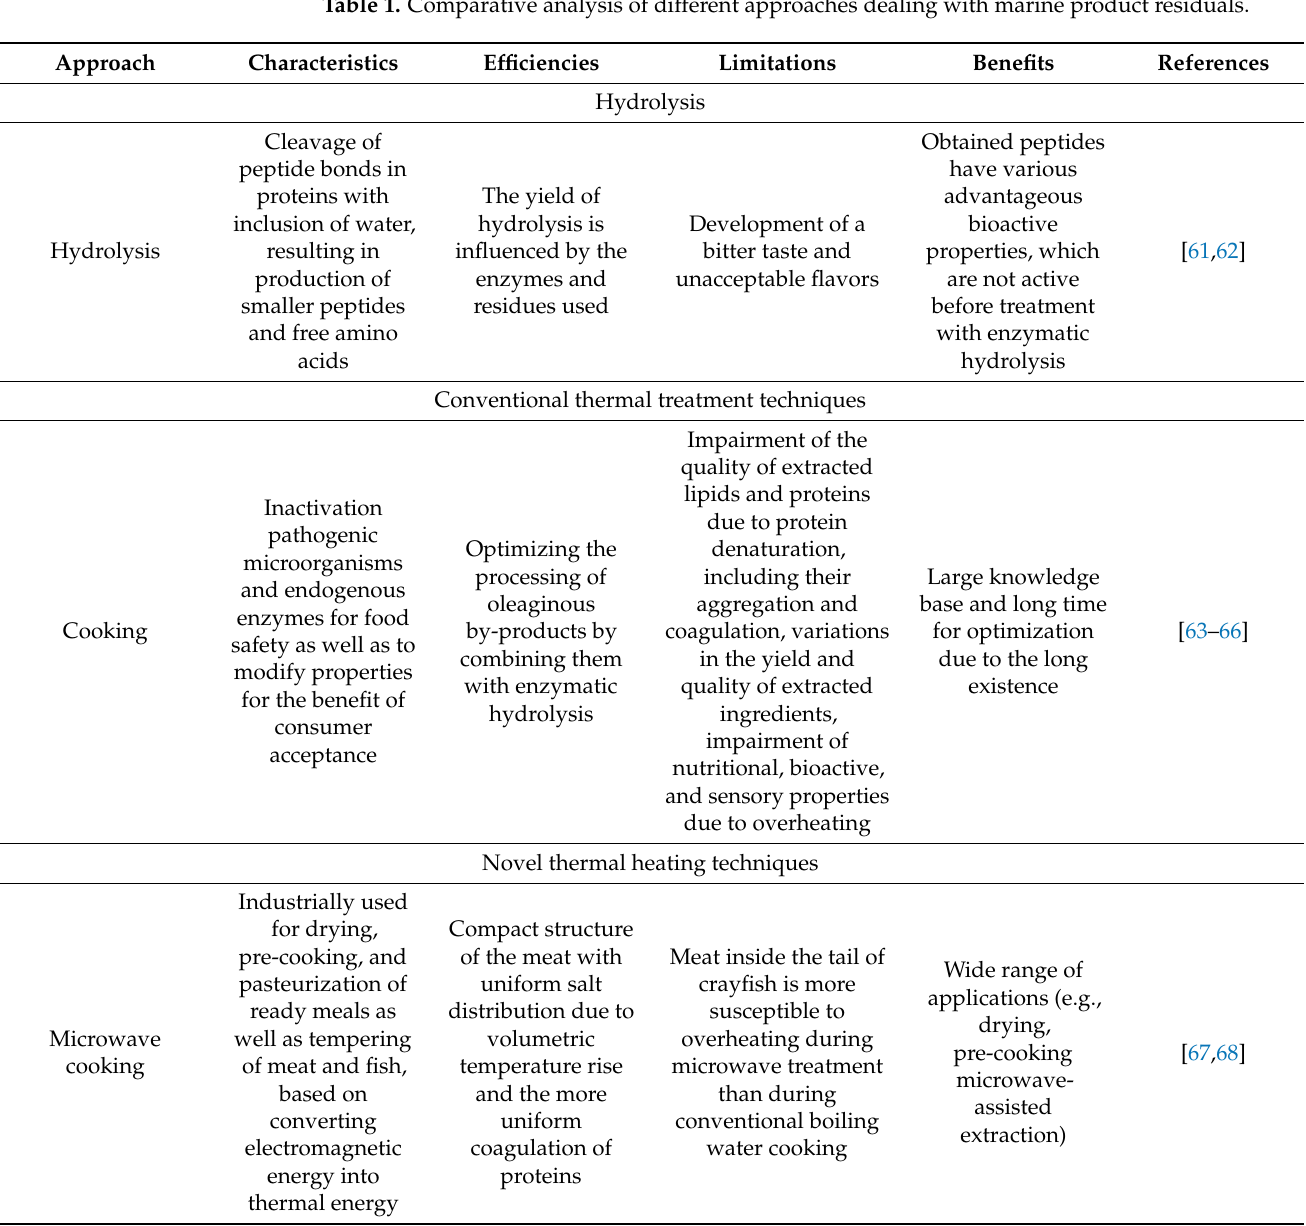
Table 1. Comparative analysis of different approaches dealing with marine product